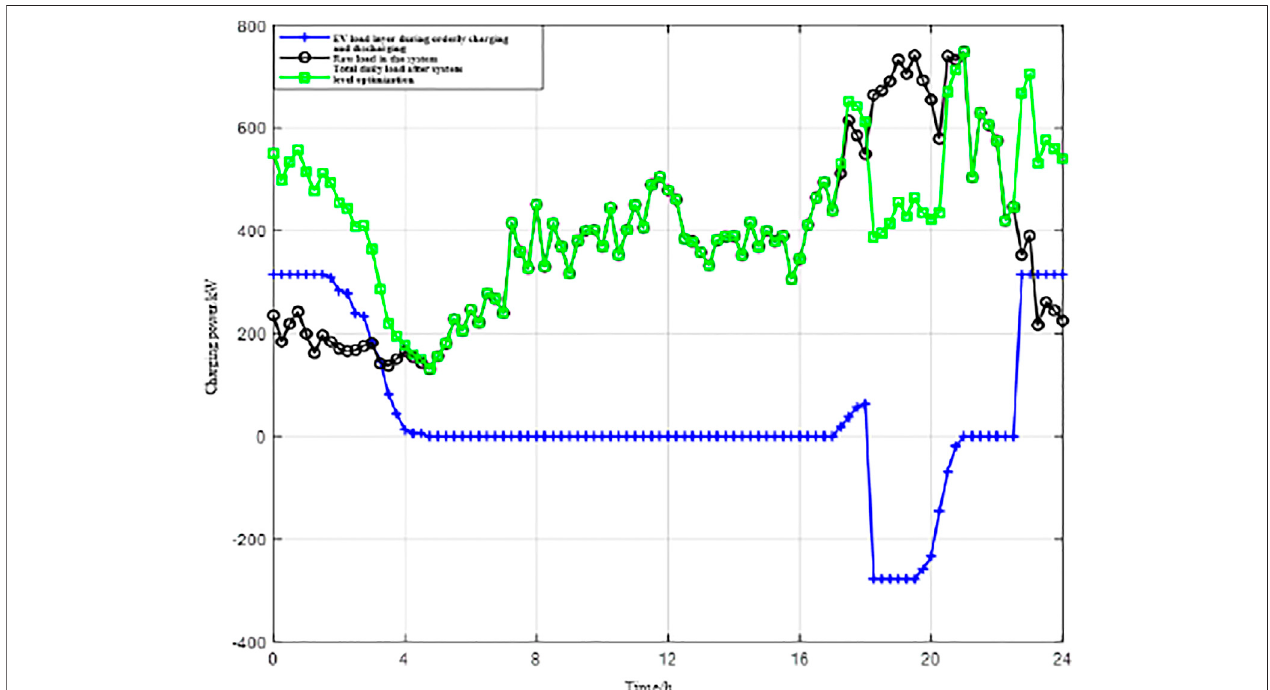
FIGURE 7 | Total daily load curve after